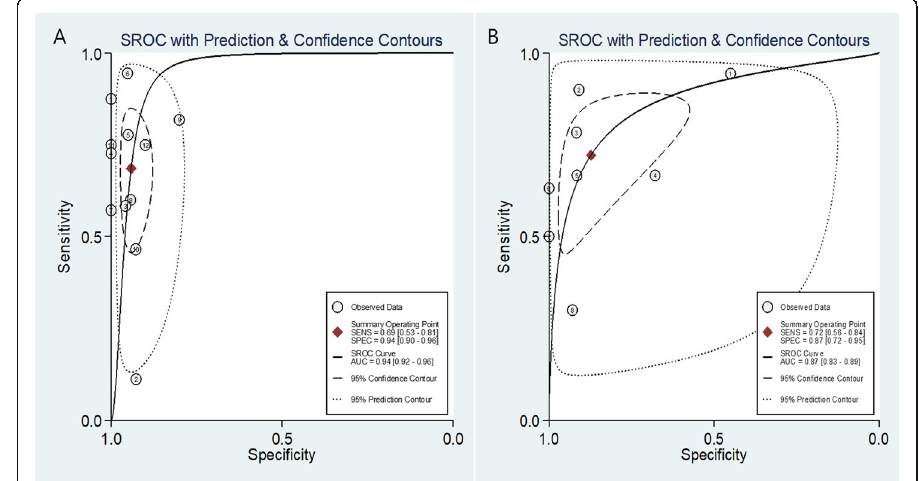
Fig. 3 Hierarchical summary receiver operating characteristic curves for PSMA-PET detecting ( a )